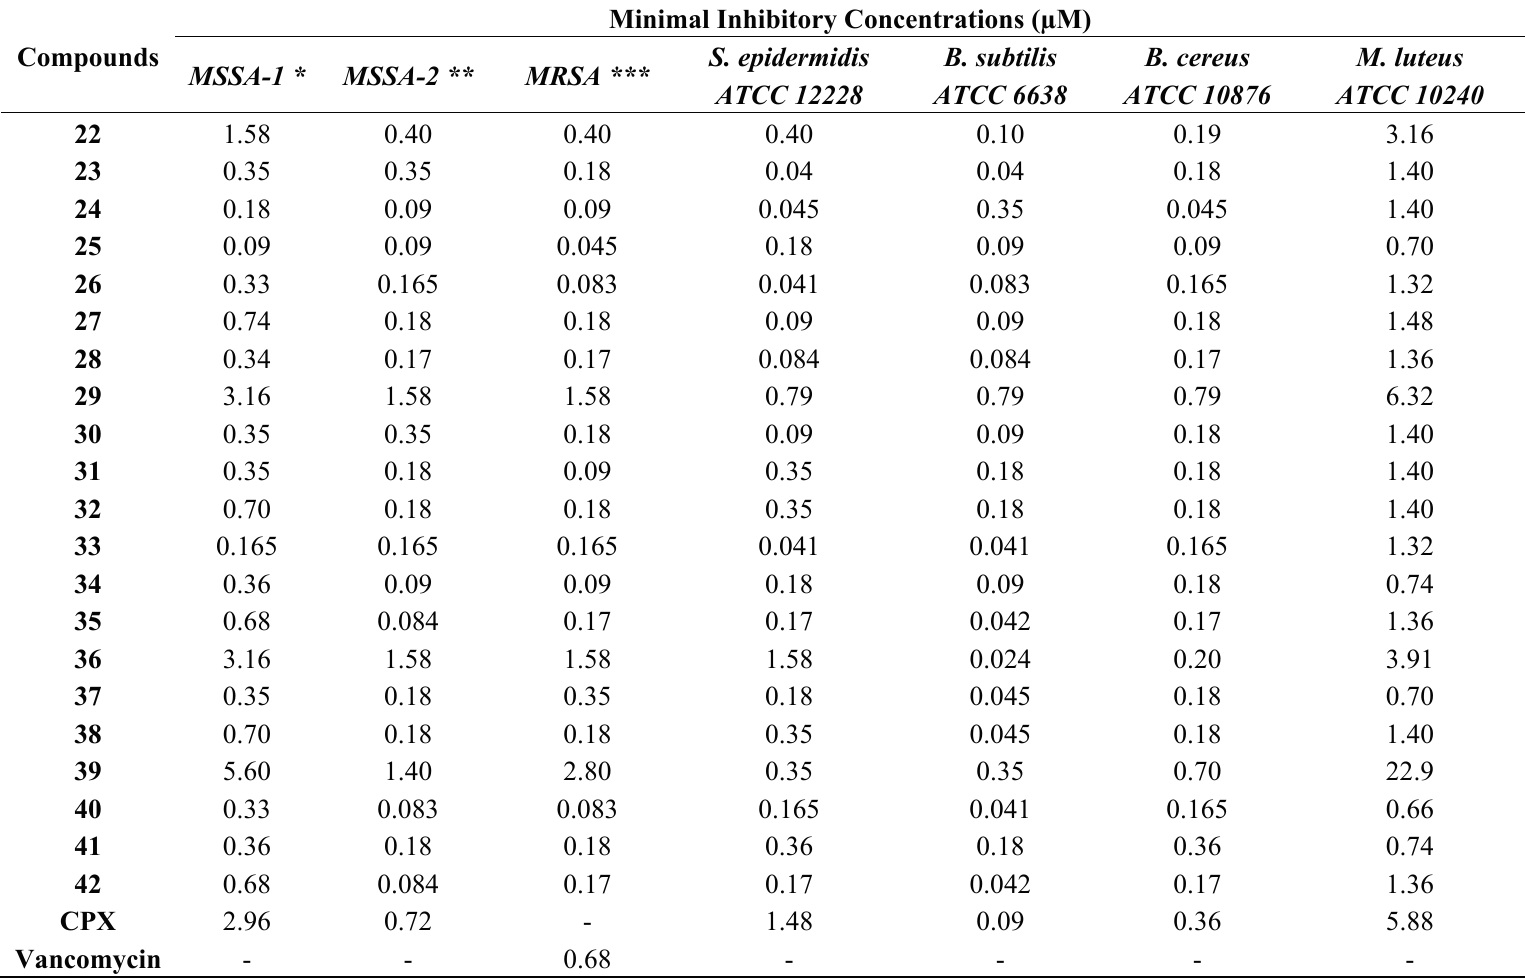
Table 2. Antibacterial activity of compounds 22 – 42 against Gram-positive